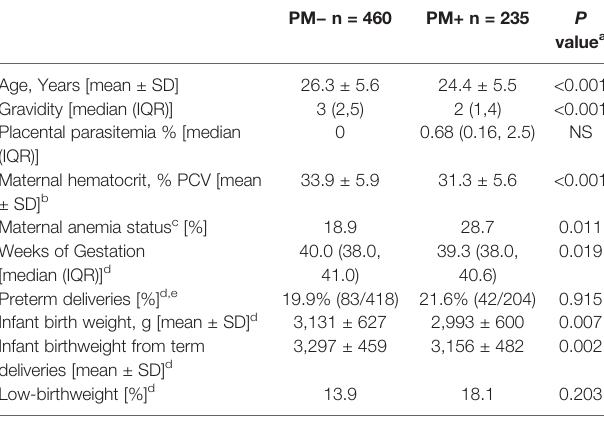
TABLE 1 | Characteristics of women with antibodies to full-length